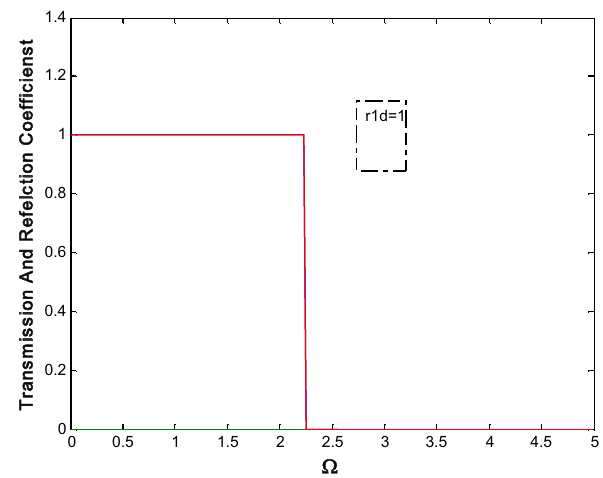
Figure 6: Transmission and re fl ection coe ffi cients in the case of homogeneous mode 1.